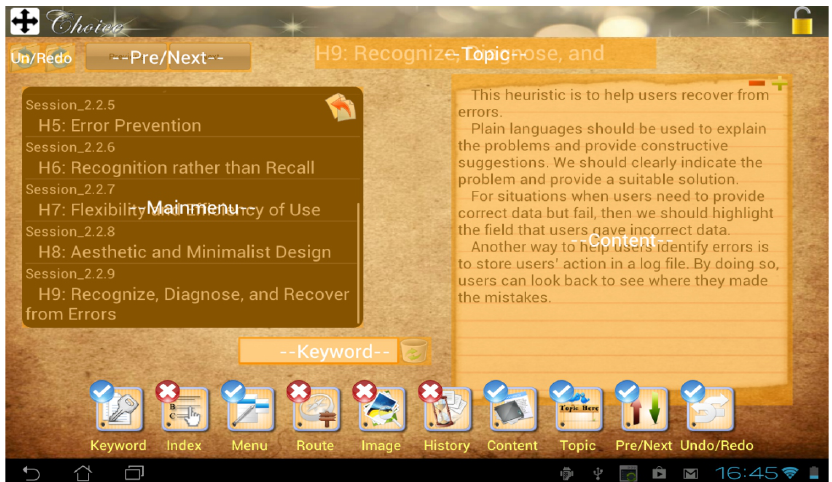
Figure 5. Display Format arranged by